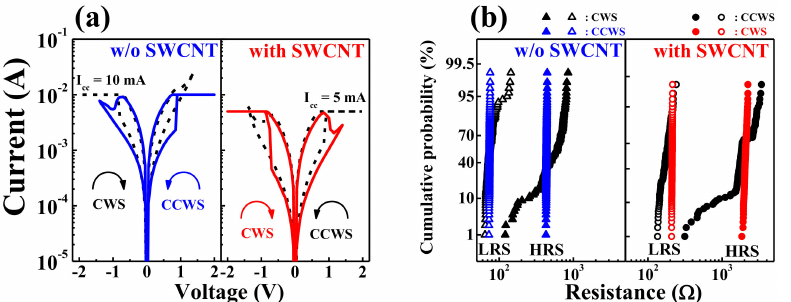
Figure 3. RS operations of HSQ memristors w/o and w/ the embedded SWCNT random network: ( a ) typical coexistence BRS operation I – V curves in clockwise switching (CWS) and counter-clockwise switching (CCWS) operations and ( b ) cumulative resistance probability during 10 2 DC cycles in CWS and CCWS